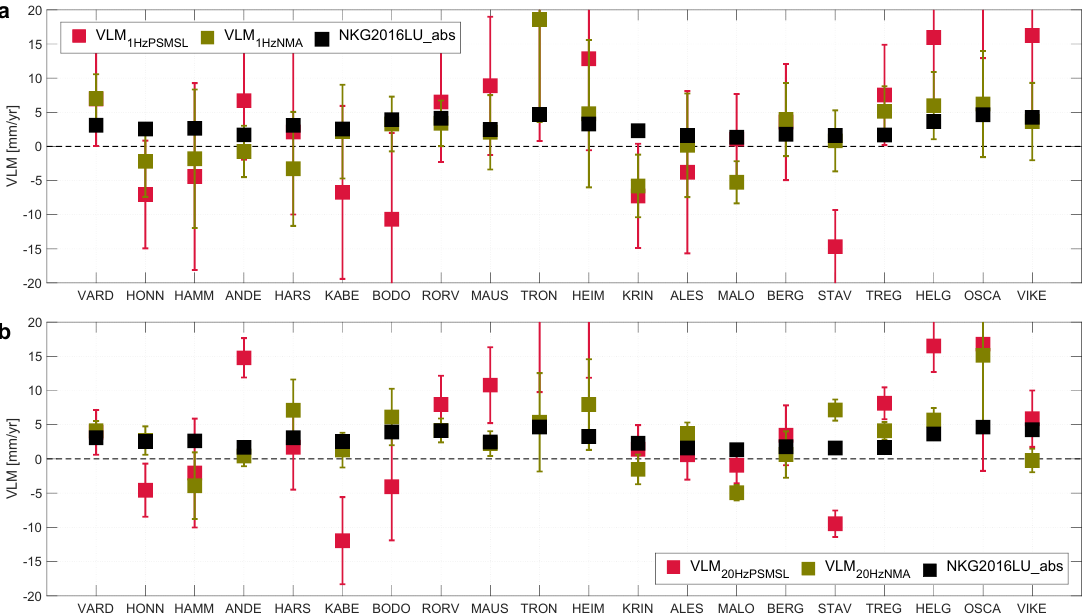
Figure 3. Rates of VLM at 20 Norwegian tide gauges. Black squares represent rates from NKG2016LU_abs, while red and green squares represent VLM calculated from tide-gauge data provided by PSMSL and NMA, respectively, and CS2 sea-level anomalies. ( a ) VLM rates based on 1 Hz CS2 time series. ( b ) VLM rates based on 20 Hz CS2 time series. The size of squares corresponds to 2 mm/year. The error bars indicate the associated uncertainties σ calculated by Equation (1), taking into account serial correlations in the measurements. The uncertainty of VLM rates from NKG2016LU_abs is 0.6 mm/year [28].